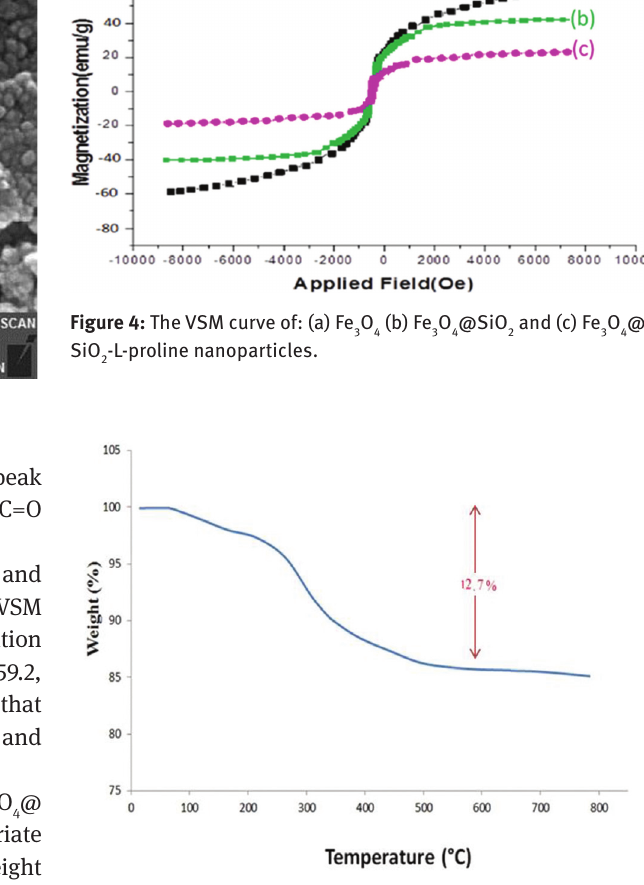
Figure 5: TGA curve of Fe